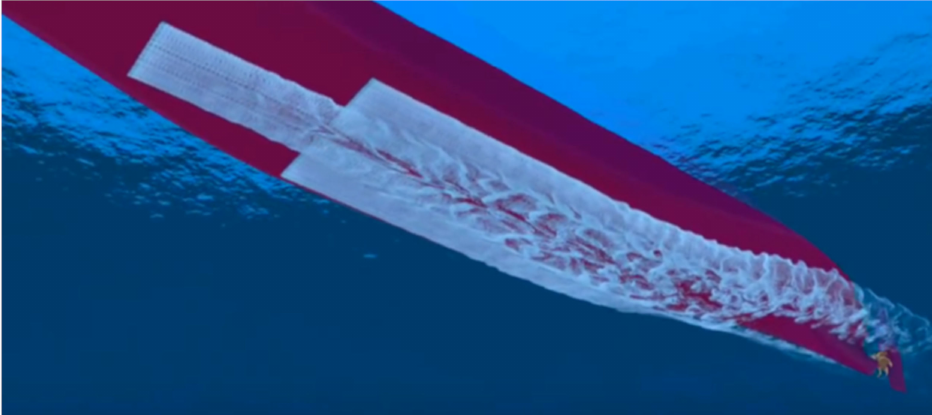
Figure 13. Mitsubishi Heavy Industries’ double curtain-formation of